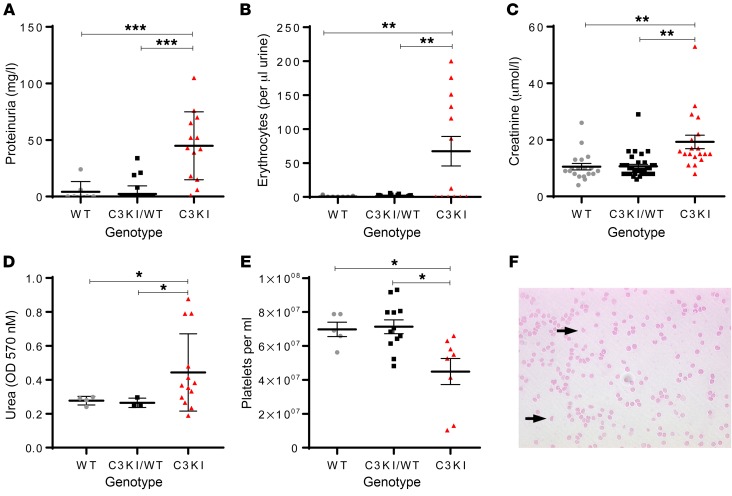
Further characterization of the C3KI mice.Where available, levels of proteinuria (A) and hematuria (B) were measured by Combistix (Siemens/Bayer) analysis of urine collected during routine handling. Results for 13 C3KI (triangles), 24 C3KI/WT (squares), and 8 WT (circles) mice, P14–P21, are shown. (C) Creatinine values obtained from the mouse plasma taken from 19 C3KI, 34 C3KI/WT heterozygous, and 19 WT mice, P14–P28, are shown. (D) Urea values obtained from plasma taken from 13 C3KI mice, 4 C3KI/WT, and 4 WT mice. (E) Platelet counts of 8 C3KI, 12 C3KI/WT, and 5 WT mice on P21. Absolute numbers were provided by use of cell count beads and flow cytometry. (F) A representative (n = 8, P21) Giemsa-stained blood film from a C3KI mouse showing schistocytes (indicated by black arrows), consistent with mechanical hemolysis of red blood cells. Original magnification ×40. *P < 0.05, **P < 0.01, ***P < 0.005 using unpaired t test with Welch’s correction.